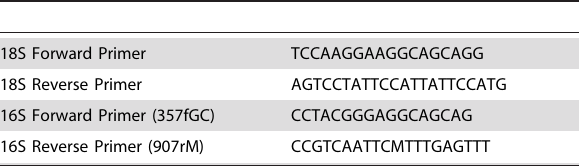
Table 1. 18S and 16S primer sequences used in the assaying of loricate choanoflagellate